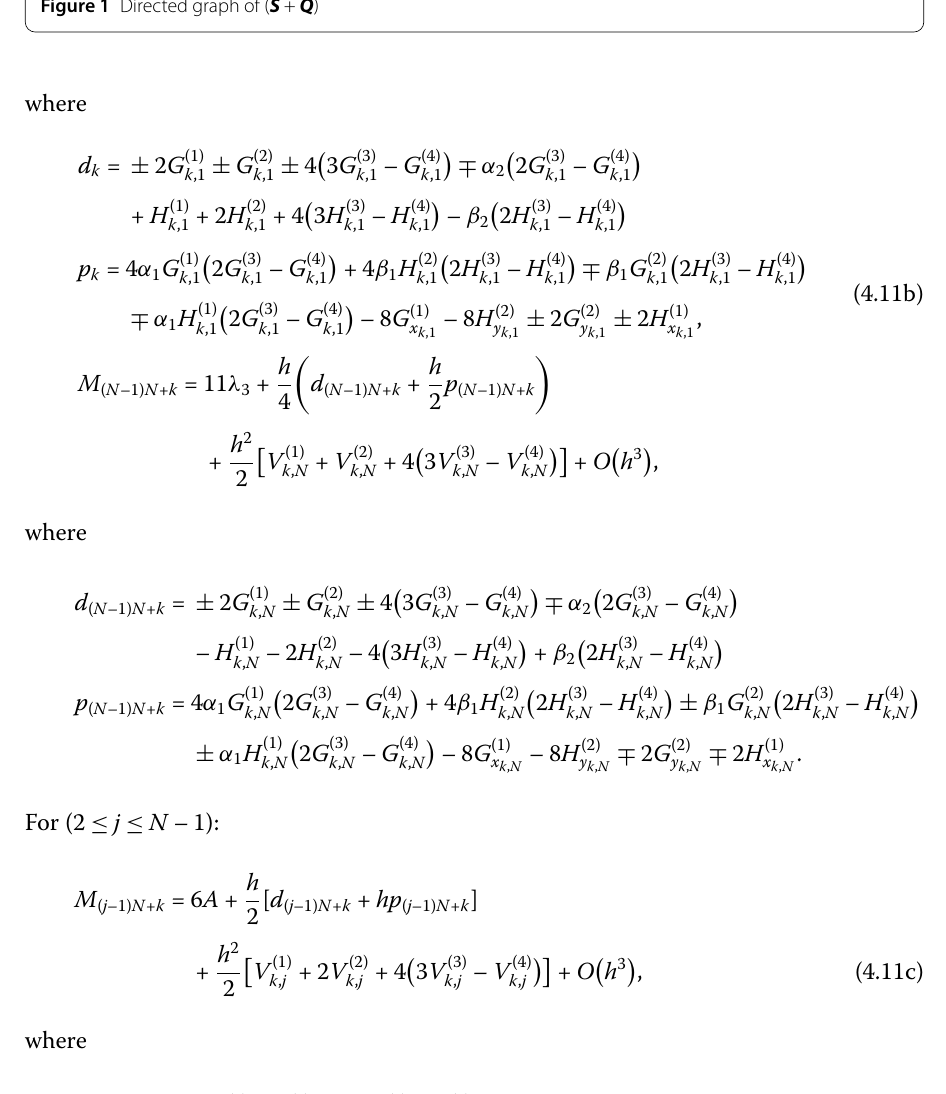
Figure 1 Directed graph of ( S + Q